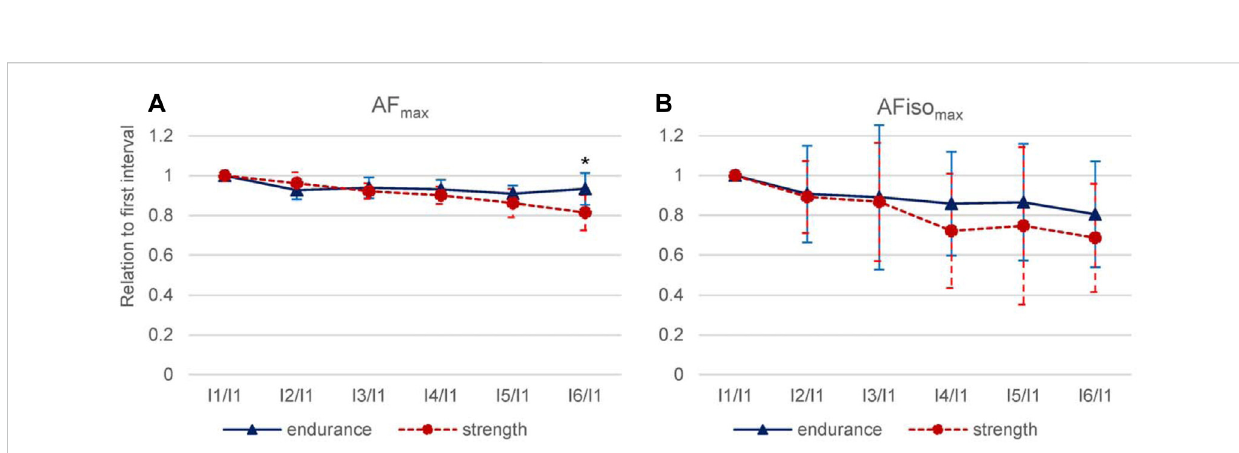
FIGURE 8 Interval relations comparing strength and endurance athletes. For AF max (A) and AFiso max (B) , the value of I1 was set at 100%, and the subsequent interval values (I2 – I6) were related to I1. M and SD (error bars) are shown for endurance (blue, n = 6) and strength (red, n = 6) athletes. Signi fi cant differences between strength and endurance athletes are indicated by * p =